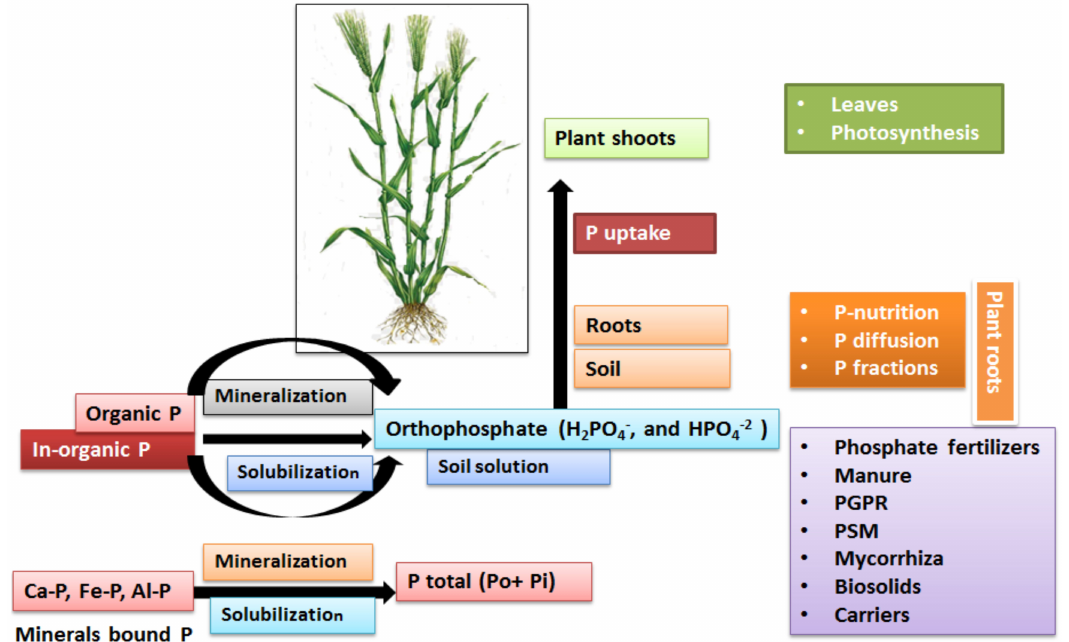
Figure 1. Mechanism of P uptake from soil to plant and associated biochemical process in the plant–soil